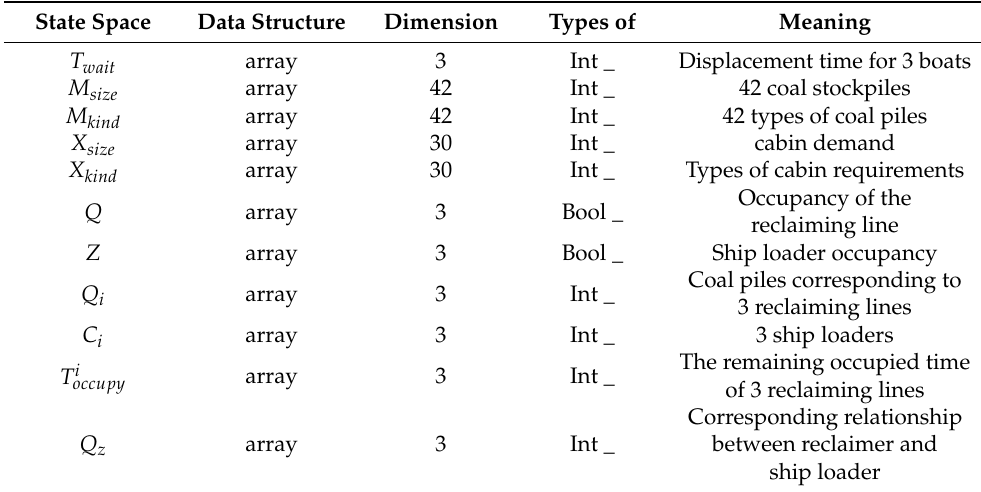
Table 2. Shipping scheduling state